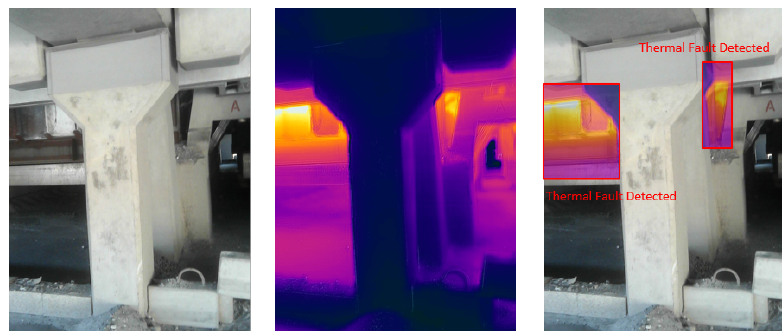
Figure 24. Thermal anomalies detection on-site for test run 2.